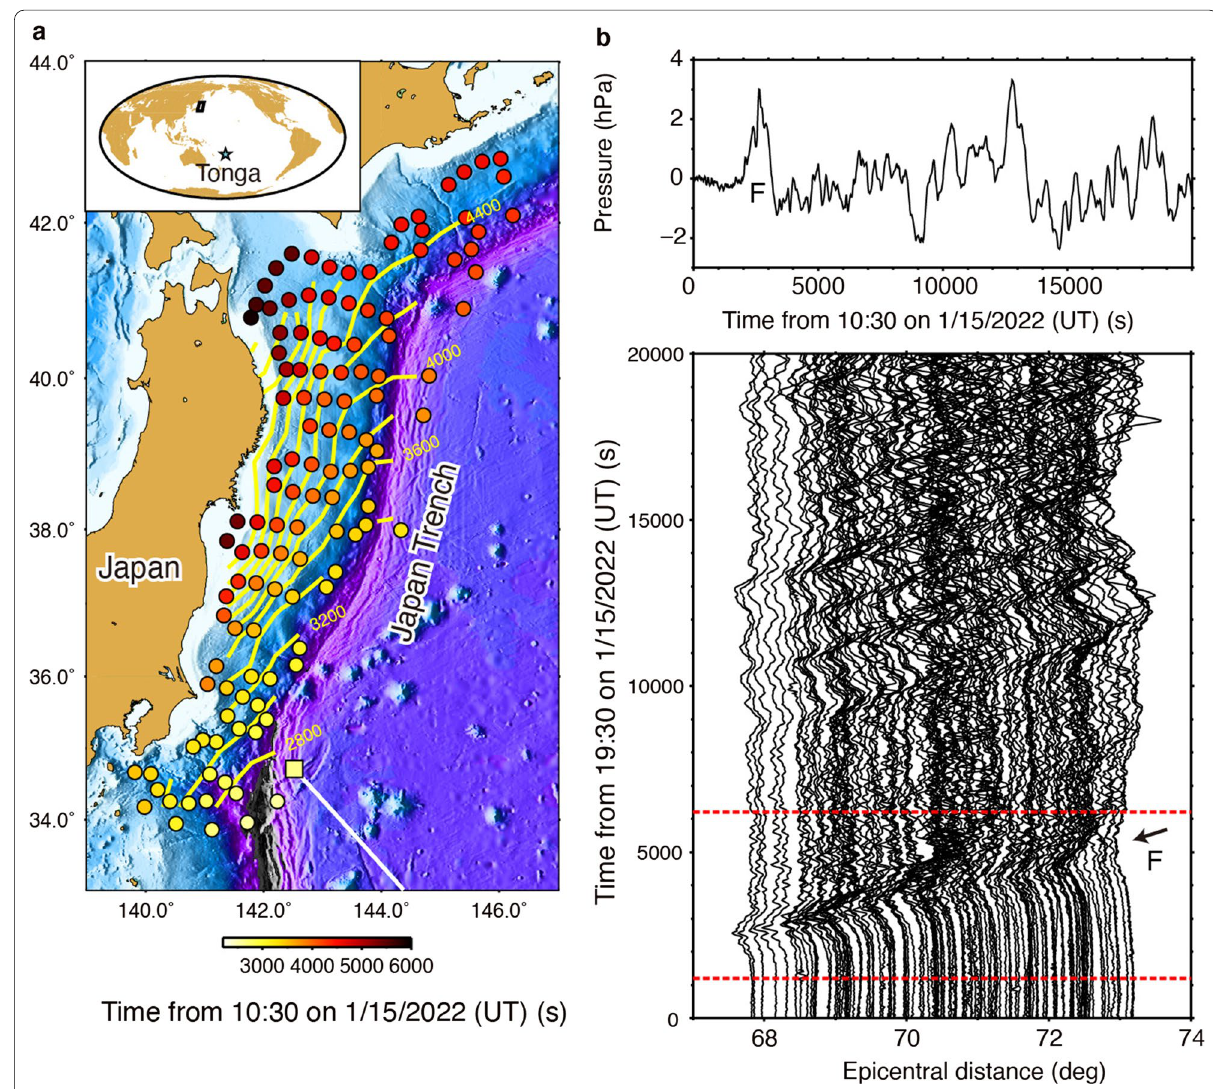
Fig. 1 Geometry of the observation for the Tonga volcanic eruption and the waveforms of the absolute pressure gauges (APGs). a Arrival times of the peaks of the meteotsunamis (label F in b ) at each station of S-net. Yellow lines show the contour lines of the arrival times. Inset represents the location of the Hunga–Tonga volcano. Square indicates the island station N.S6N19. The white line connects the N.S6N19 with the Tonga volcano along the great circle. b APG waveform after removing the long-period components for (top) a station N.S6N19 and (bottom) all of the used stations. The red dashed lines represent the time window of 5000 s for searching the arrival times of the first